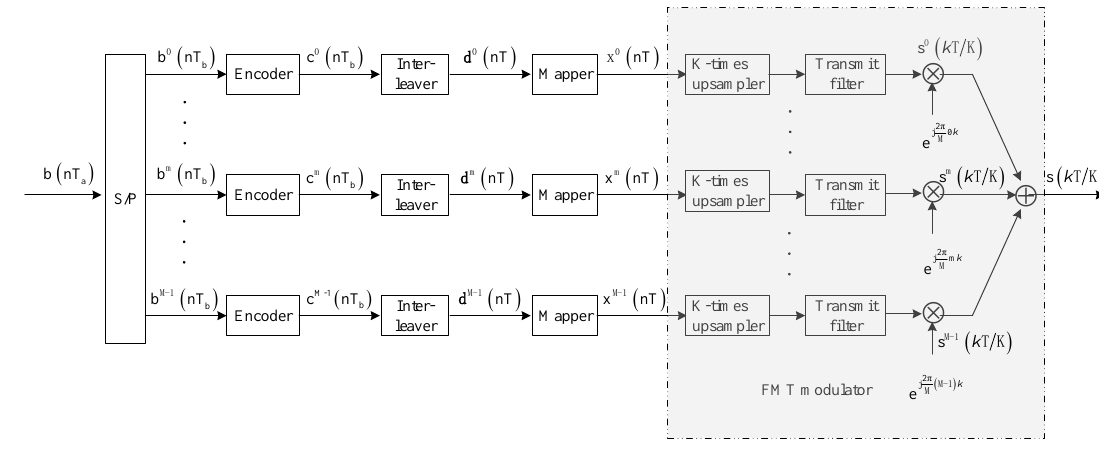
Figure 1. Block diagram for transmitter structure.